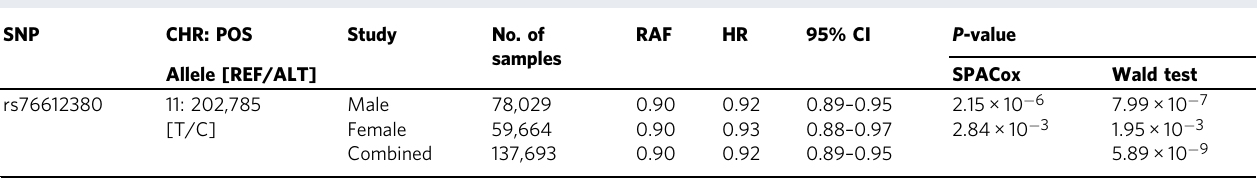
Table 1 Meta-analysis of the sex-strati fi ed